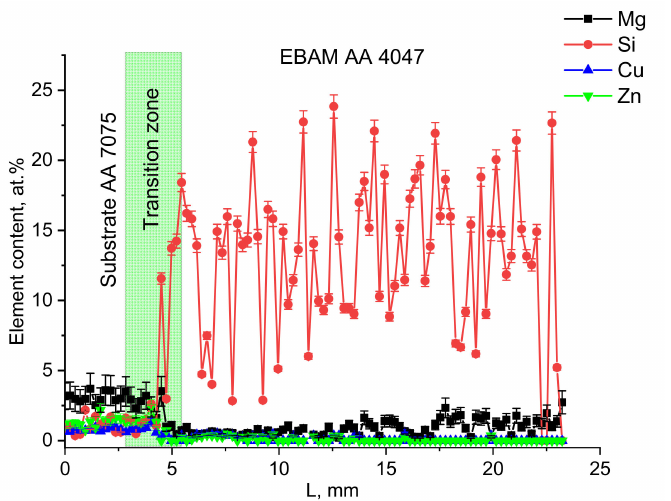
Figure 5. EDS profiles for Mg, Si, Cu and Zn as measured along the wall